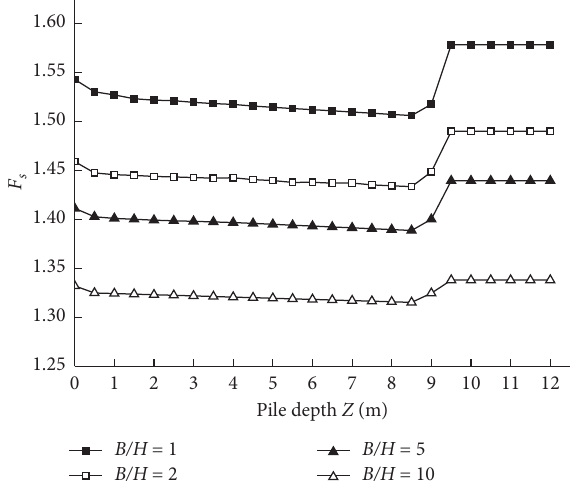
Figure 9: Effects of the B / H ratio on the stability of 3D slopes.